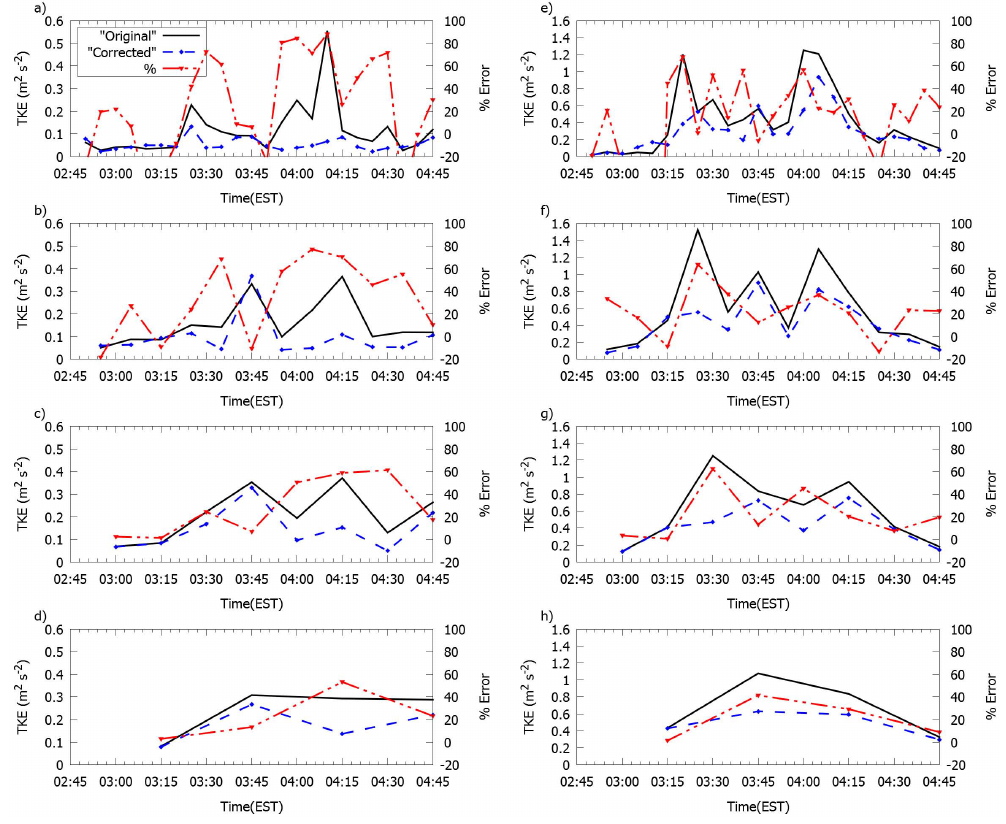
Fig. 4. Turbulent Kinetic Energy (TKE) calculations using the original signal (solid) and the corrected signal (dashed) after wave removal from the time series at 34 and 329m levels on the tall tower using different averaging periods (5 (a, e) , 10 (b, f) , 15 (c, g) , and 30min (d, h) ) on 23 April 2009. The percent error (“dot-dashed”) is also